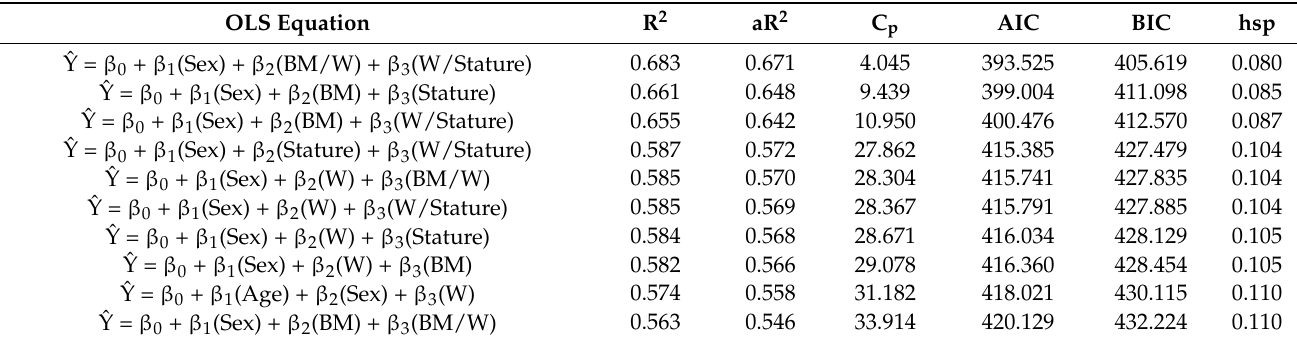
Table 3. Regression results to estimate fat mass using DXA as the